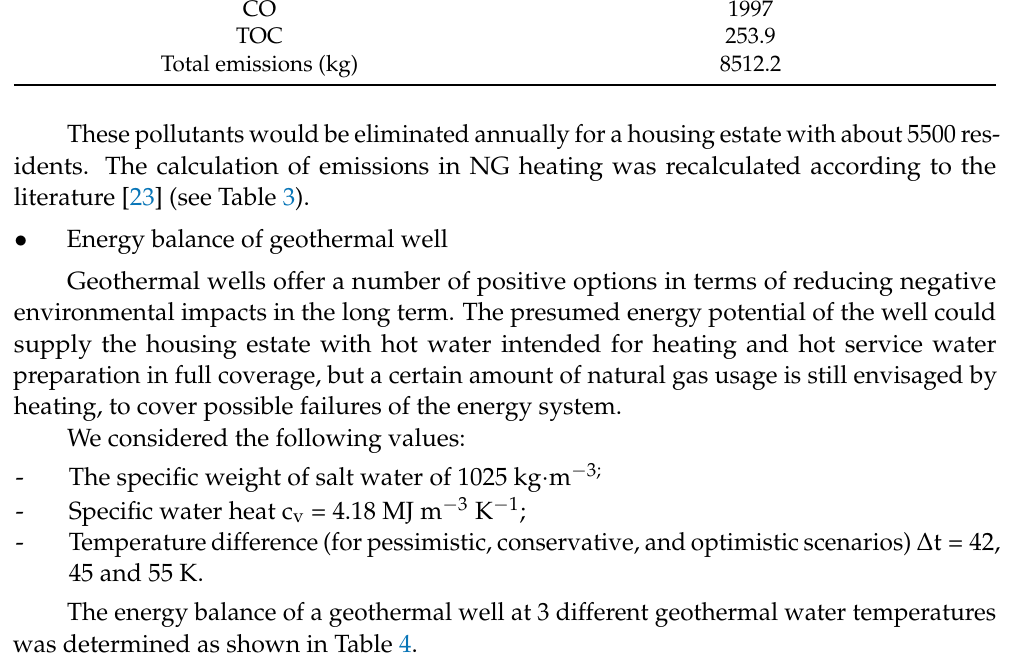
Table 4. Energy balance of geothermal well